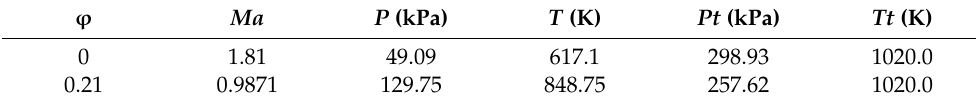
Table 2. Flow Properties at the entrance of combustor after mass-weighted averaging.